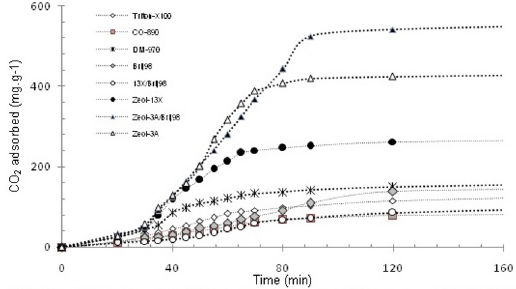
Figure 5. Adsorption breakthrough curves of CO2 over TEOS/ CO-890; TEOS/DM-970; TEOS/Brij98; 13X/Brij98; TEOS/ Triton-X-100; 3A/Brij98; Zeol-13X and Zeol-3A. Table 3: Values of the kinetics model parameters